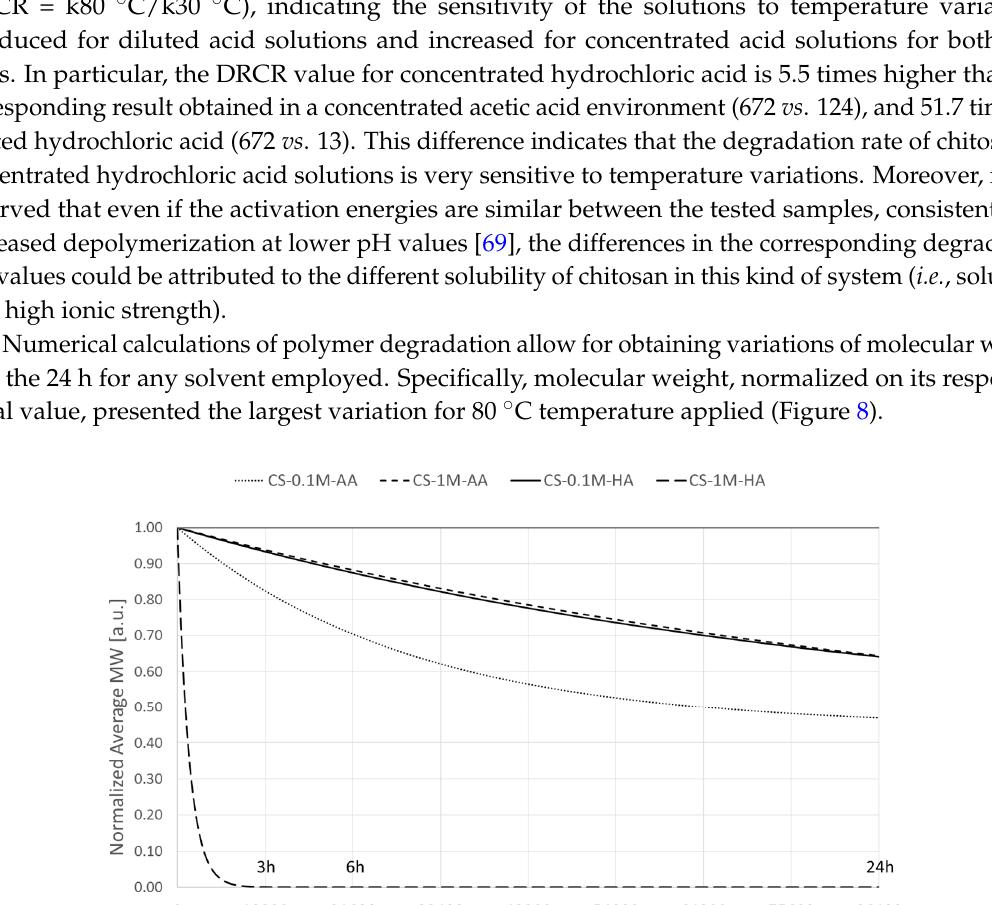
Table 4. Percentage of variation of measured viscosity with respect to its values calculated by means of MHS, maximum and minimum absolute variations are highlighted.